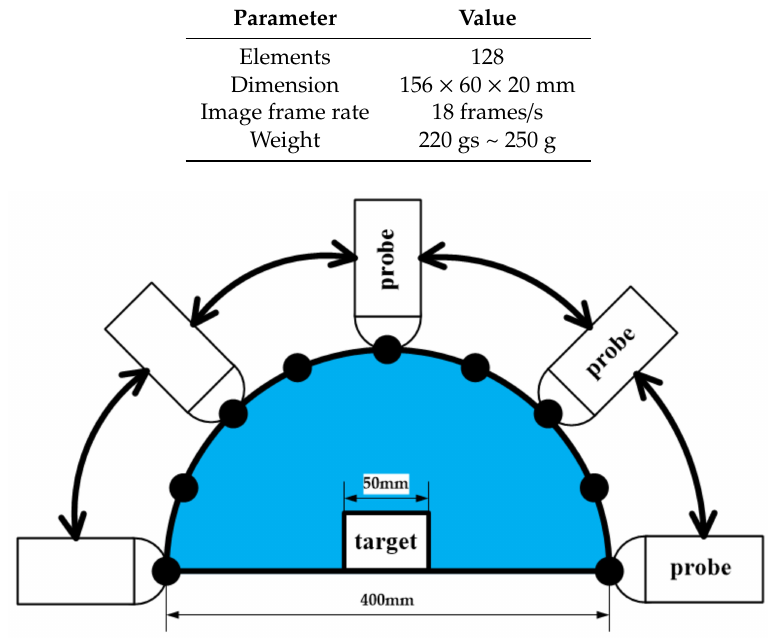
Figure 14. The experiment with the real